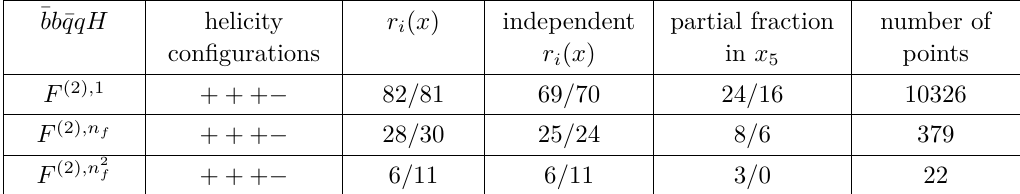
Table 2. Maximum numerator/denominator polynomial degrees of the finite remainder coefficients r i ( x ) in eq. (3.3) at each stage of our reconstruction steps, together with the number of sample points needed for the analytic reconstruction in the ¯ bb ¯ qqH subprocess, for the various closed fermion loop